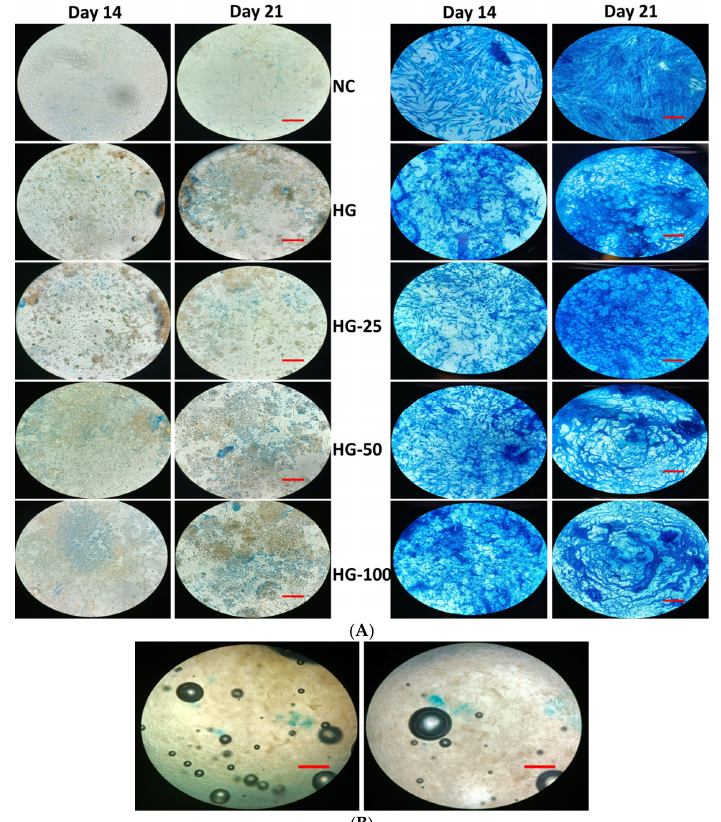
Figure 9. Alkaline phosphatase staining of osteogenic cells differentiated from MSC cultured on hydrogels for 14 and 21 days. Cells without osteogenic supplement ( Left ) and cells with osteogenic supplement ( Right ). ( A ) Cells cultured on hydrogels and stained, ( B ) only hydrogels with ALP stain without cells and supplement. NC—cells without hydrogels, HG—hydrogels without VEGF, HG-25, -50, and -100—hydrogels with 25 ng/mL, 50 ng/mL, and 100 ng/mL of VEGF, respectively. Scale bar 10×—100 µm. Similar to mineral staining, the cells with an osteogenic culture medium and osteogenic supplements expressed more positive staining for ALP both on days 14 and 21 and the level of expression was increased with increasing culture time. The network formation of cells on HGs is clearly seen by ALP staining in Figure 9. On day 14, the amount of ALP staining was higher in cells cultured on a control HG compared to control cells and at the same time, the level of ALP was expressed more in VEGF-loaded HGs than in control HGs on days 14 and 21. Among the HGs, the VEGF-loaded HGs had more ALP staining than control HGs and the e ff ect was more pronounced in a higher concentration of VEGF-loaded HGs compared to other VEGF-loaded HGs. The blank HGs treated without cells, an osteogenic culture medium, or osteogenic supplements did